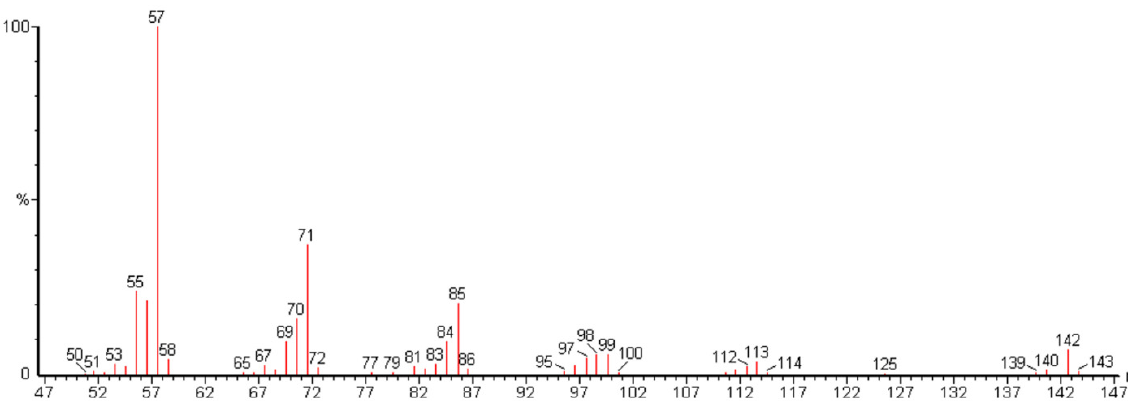
Table 2. BTEX concentrations in liquid and gaseous phases of diesel oil in equilibrium at a tem- perature of 40 °C.